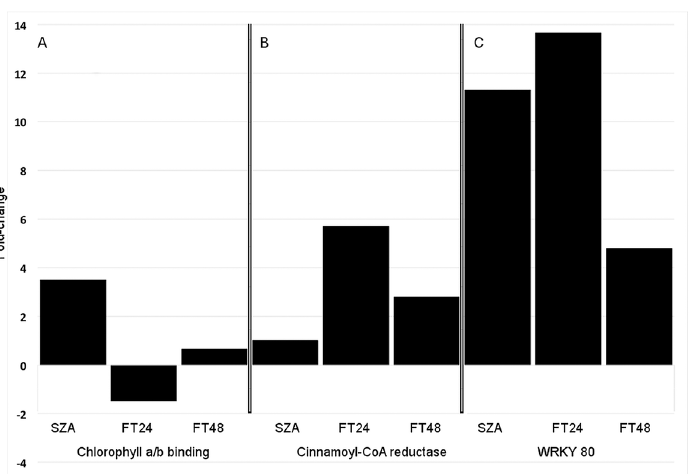
Fig 5. Expression level fold-changes of three classes of genes in wheat crowns following freeze-thaw treatments. Fold changes were determined with quantitative real-time PCR. SZA: subzero acclimation, − 3°C for 24 hours; FT24: freeze/thaw 24 hours, frozen to − 3°C for 24 hours then allowed to thaw at +3°C for 24 hours; FT48: freeze/thaw 48 hours, frozen to − 3°C for 24 hours then allowed to thaw at +3°C for 48 hours. (A) Chlorophyll a/b binding gene expression fold-change shown represents the mean of six genes. (B) Cinnamoyl-CoA reductase is a key gene of the phenylpropanoid biosynthetic pathway. (C) transcription factor